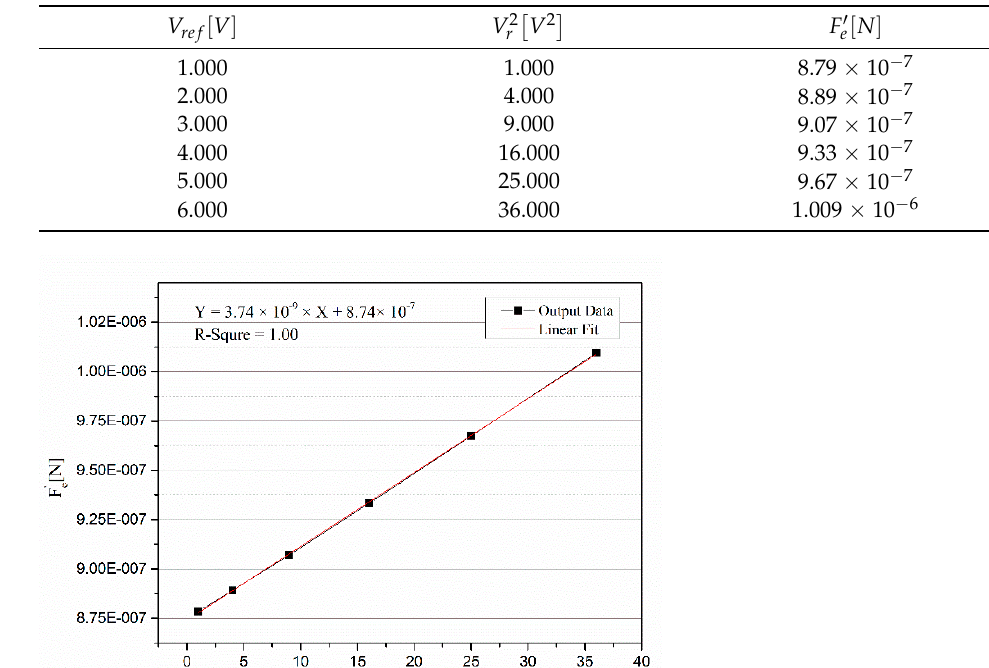
Table 2. Data of measuring mismatch of parasitic capacitance.